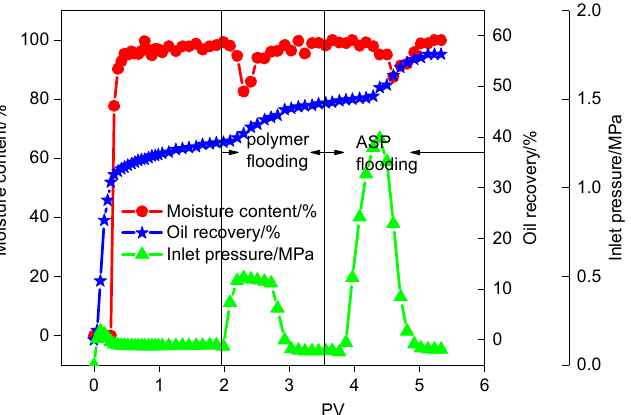
Figure 12. Curves of the injection and production of ASP flooding after polymer flooding.